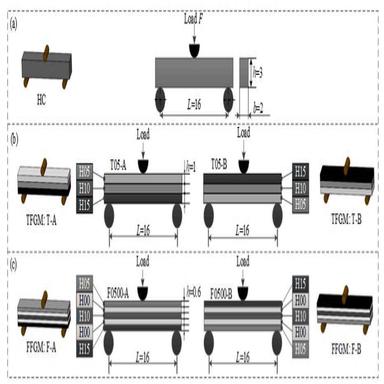
Specimen size for three-point bending tests of TiB2/Al7050 composites (mm): (a) HC; (b) TFGM; (c) FFGM.